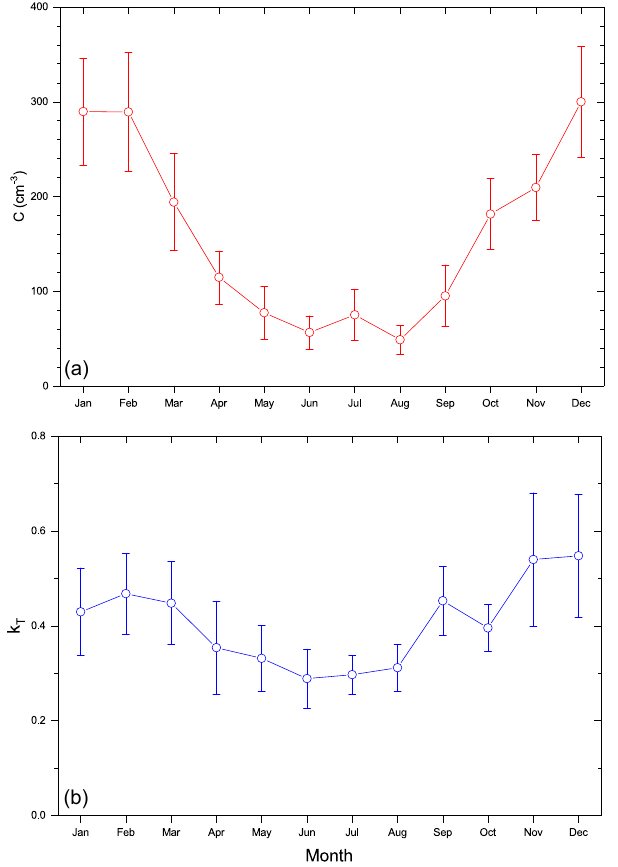
Figure 11. Seasonality of monthly mean values of (a) C and (b) k T over the whole observation periods. The error bar represents the standard deviation of the measurements from the mean value.